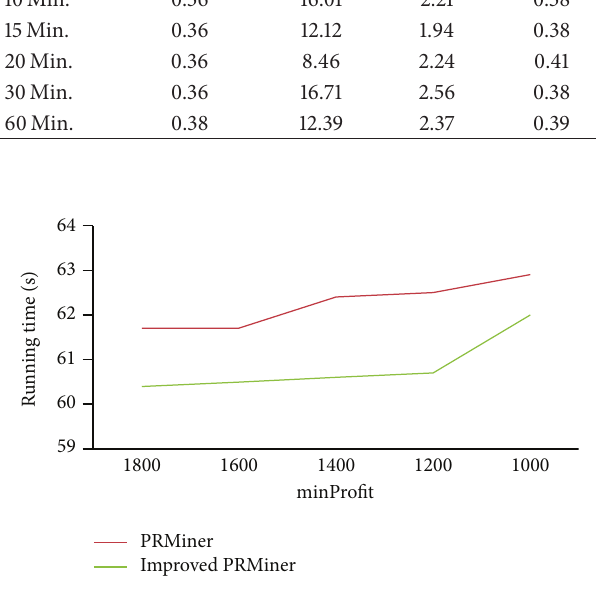
Figure 6: Performance comparison for various minProfit